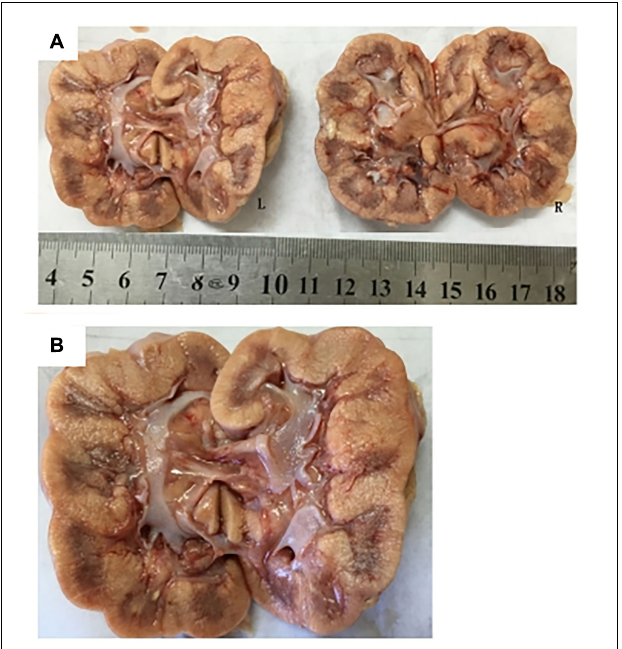
FIGURE 2 | Postmortem examination was performed on III:4 of the family. (A,B) No visible stone was found on the bilateral kidneys of III:4.